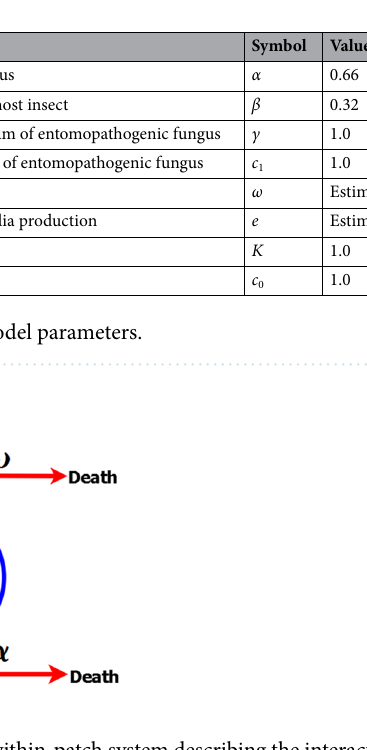
Figure 6. Model diagram of the within-patch system describing the interactions between the entomopathogenic fungus and host insect inside a patch model. Yellow color on the diagram denotes the entomopathogenic fungus M. acridium, green color denotes host insect population (desert locust), blue circle denotes interactions between the entomopathogenic fungus and the host insect, red arrow denotes death. See Table 2 for detailed model explanation and parameters definitions (adapted from 62